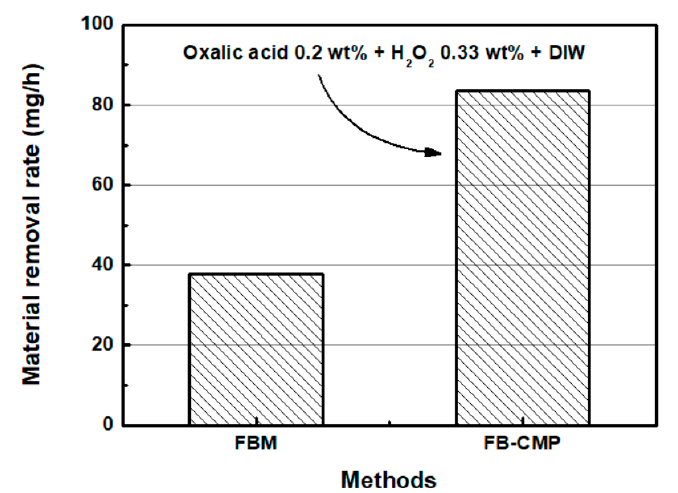
Figure 14. Material removal rates of FBM and FB-CMP (H 2 O 2 concentration: 0.33 wt %, and oxalic acid concentration: 0.2 wt %).